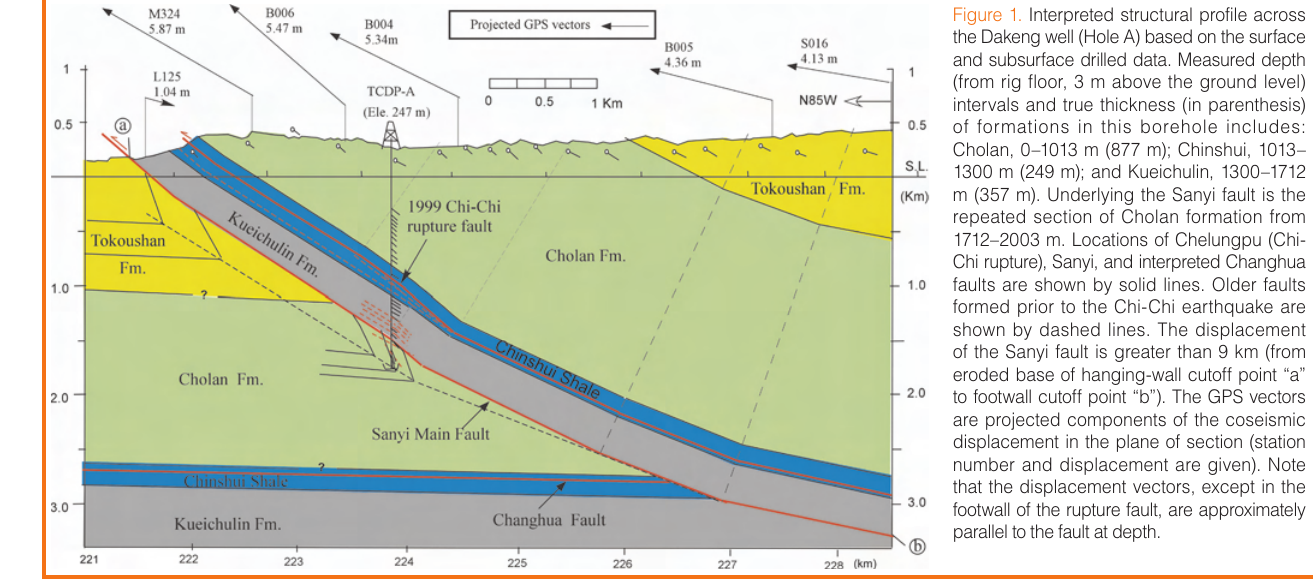
Figure 1. Interpreted structural profile across the Dakeng well (Hole A) based on the surface and subsurface drilled data. Measured depth (from rig floor, 3 m above the ground level) intervals and true thickness (in parenthesis) of formations in this borehole includes: Cholan, 0–1013 m (877 m); Chinshui, 1013– 1300 m (249 m); and Kueichulin, 1300–1712 m (357 m). Underlying the Sanyi fault is the repeated section of Cholan formation from 1712–2003 m. Locations of Chelungpu (Chi- Chi rupture), Sanyi, and interpreted Changhua faults are shown by solid lines. Older faults formed prior to the Chi-Chi earthquake are shown by dashed lines. The displacement of the Sanyi fault is greater than 9 km (from eroded base of hanging-wall cutoff point “a” to footwall cutoff point “b”). The GPS vectors are projected components of the coseismic displacement in the plane of section (station number and displacement are given). Note that the displacement vectors, except in the footwall of the rupture fault, are approximately parallel to the fault at